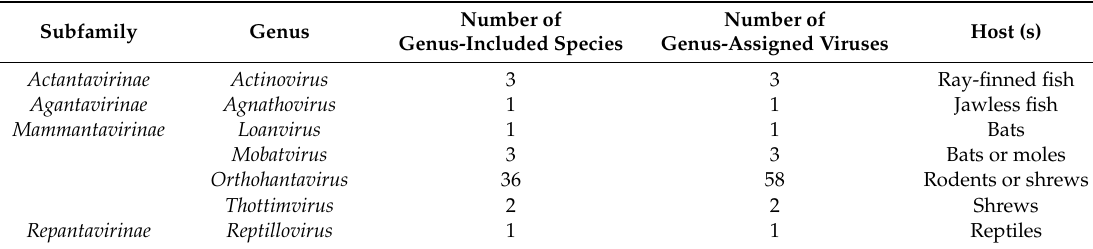
Table 3. Classification overview of Hantaviridae in 2019 [32].